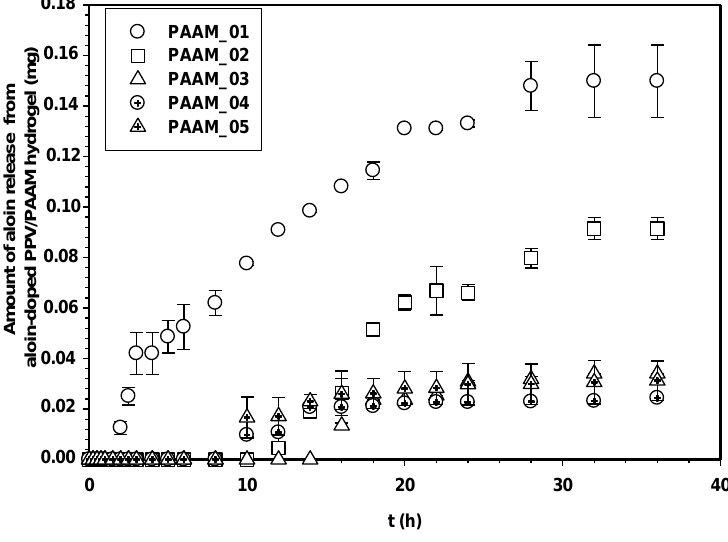
Figure 7. Amounts of aloin released from aloin-doped PPV/PAAM hydrogel at various crosslinking ratios, E = 0 V, pH = 5.5, and at 37 °C.